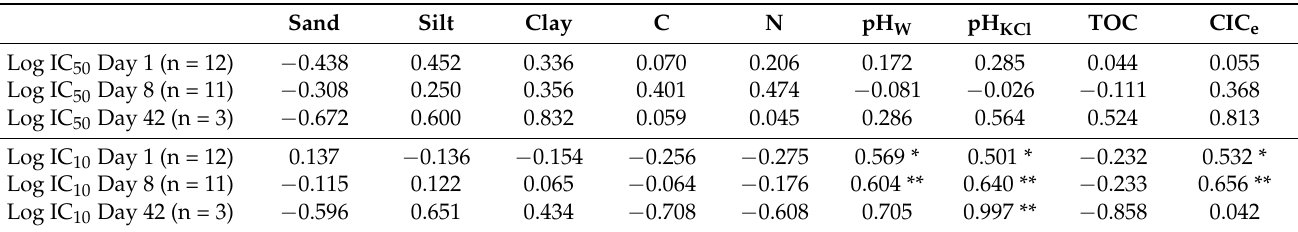
Table 3. Pearson correlation coefficients between soil characteristics and Log IC 50 /IC 10 values estimated after 1, 8, and 42 days of